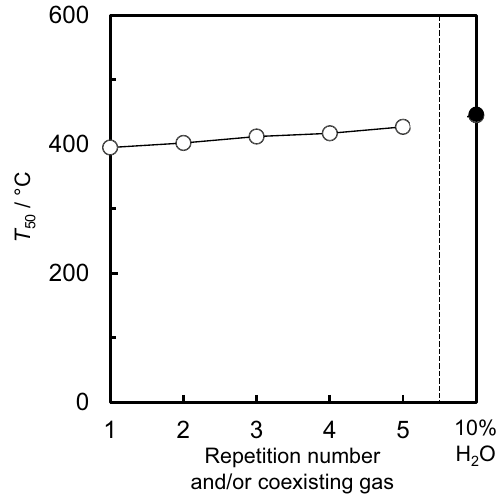
Figure 7. Catalytic activity ( T 50 ) for the N 2 O decomposition reaction over 5.0 wt% Ru/SnO 2 as a function of the repetition number, and the effects of water vapour (10% H 2 O). Reaction conditions: 200 ppm of N 2 O, 10% O